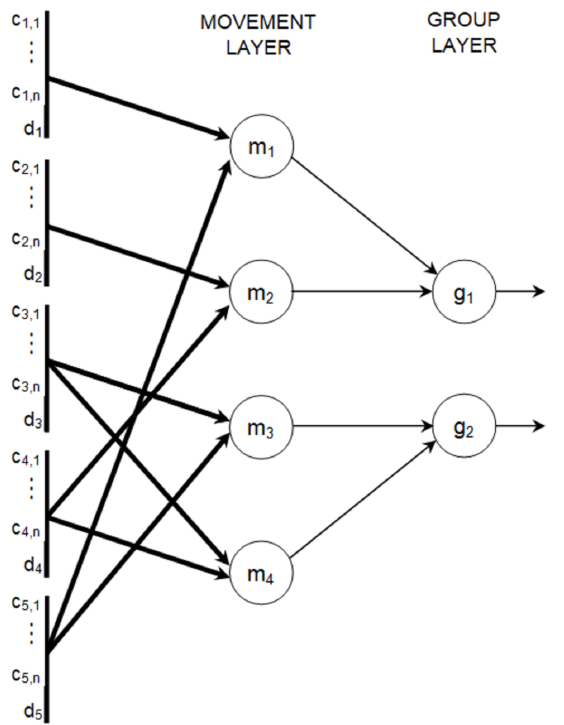
Figure 3. Topology of the data aggregation module for the intersection in Figure